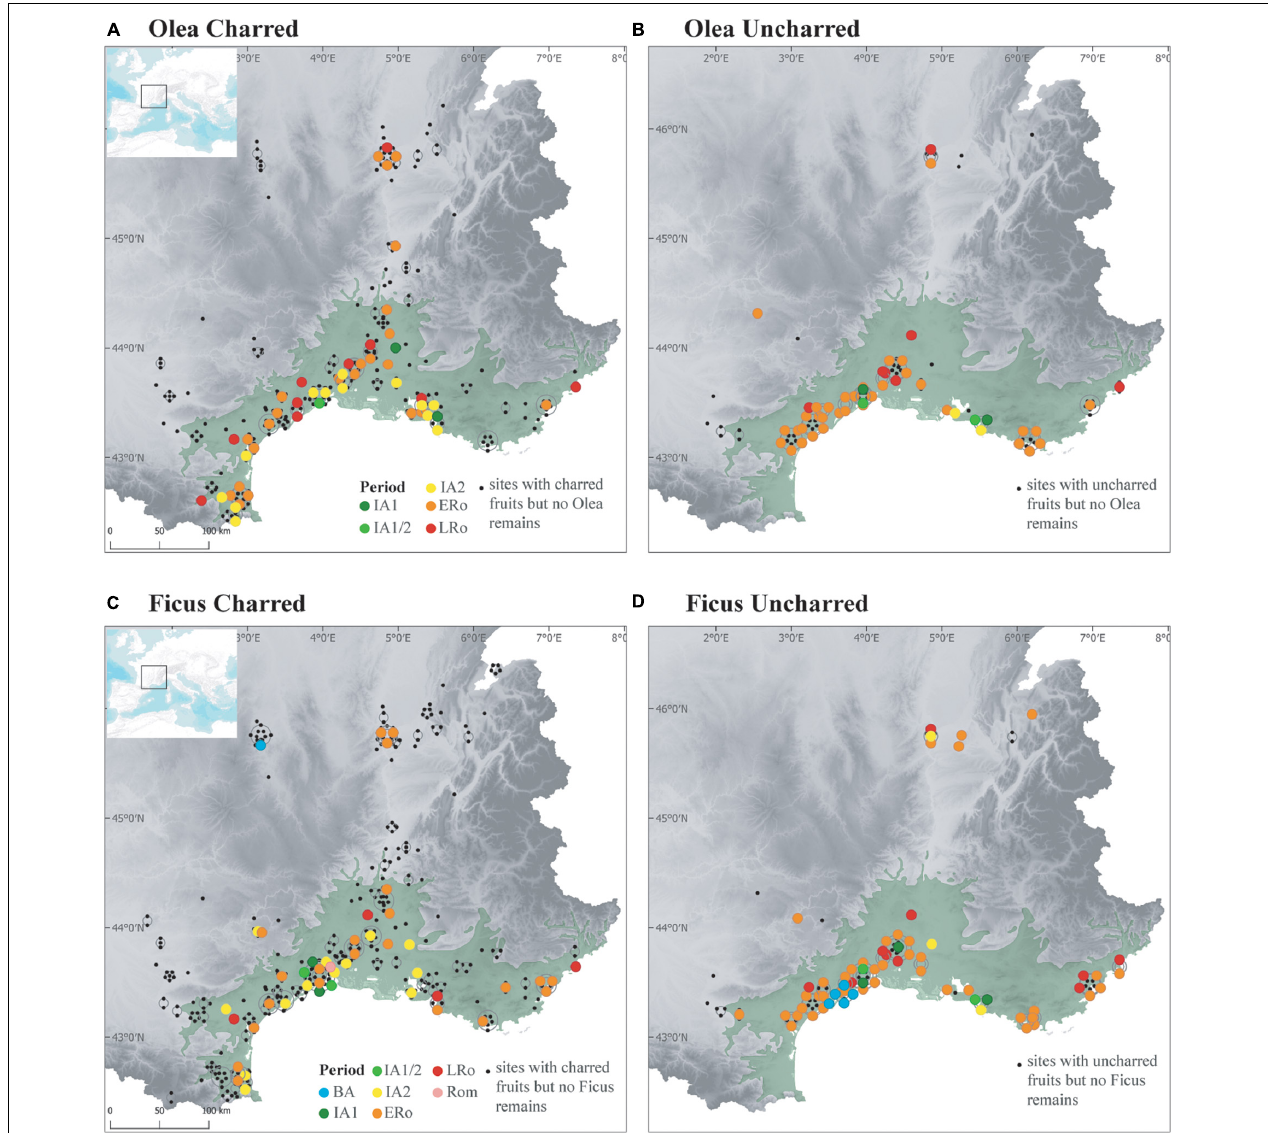
FIGURE 9 | Maps showing the distribution of (A,B) Olea finds in Iron Age and Roman sites, (C,D) Ficus finds in Bronze Age-Iron Age and Roman sites, according to preservation type ( A,C , Charred; B,D,